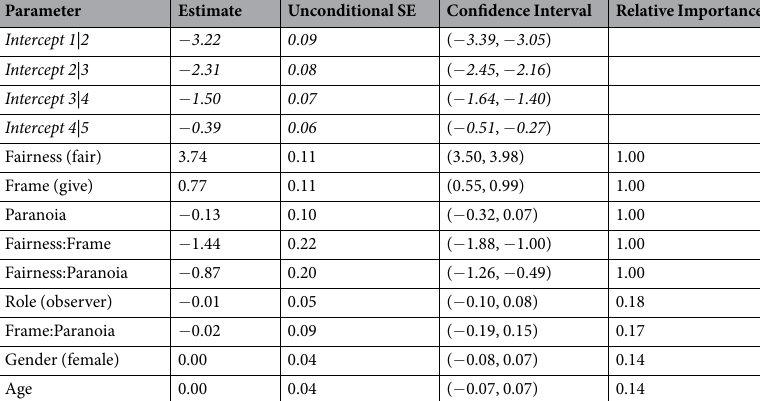
Table 2. Factors affecting attribution of self-interest. Model averaged estimates, unconditional standard errors, confidence intervals and relative importance for the terms included in the top model set (Table S2). The response term for the model was a five-level, ordered categorical variable, indicating the extent to which participants attributed self-interest to dictators. Input variables were scaled so estimates can be considered on the same